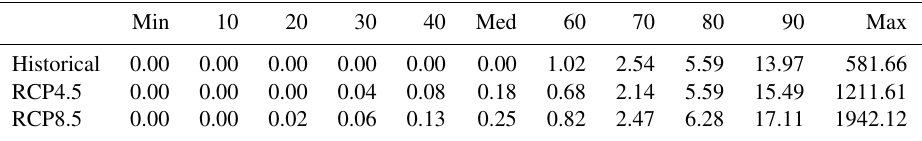
Table C2. Daily total precipitation (mm) quantiles for the observed historical GHCN climate, the downscaled RCP4.5 climate, and the downscaled RCP8.5 climate using the UK’s